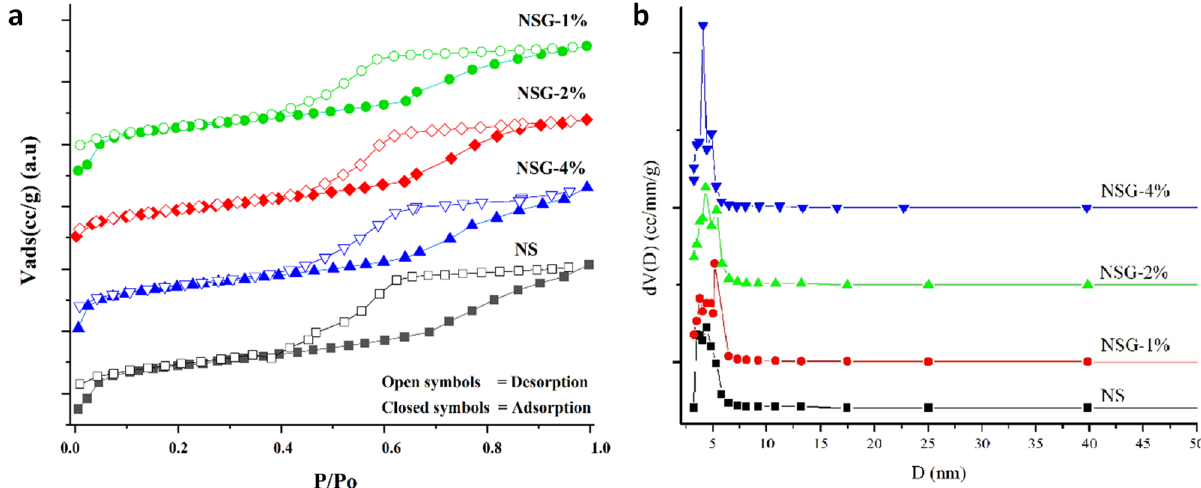
Figure 4. N 2 adsorption–desorption isotherm ( a ) and Pore size distribution ( b ) of samples.